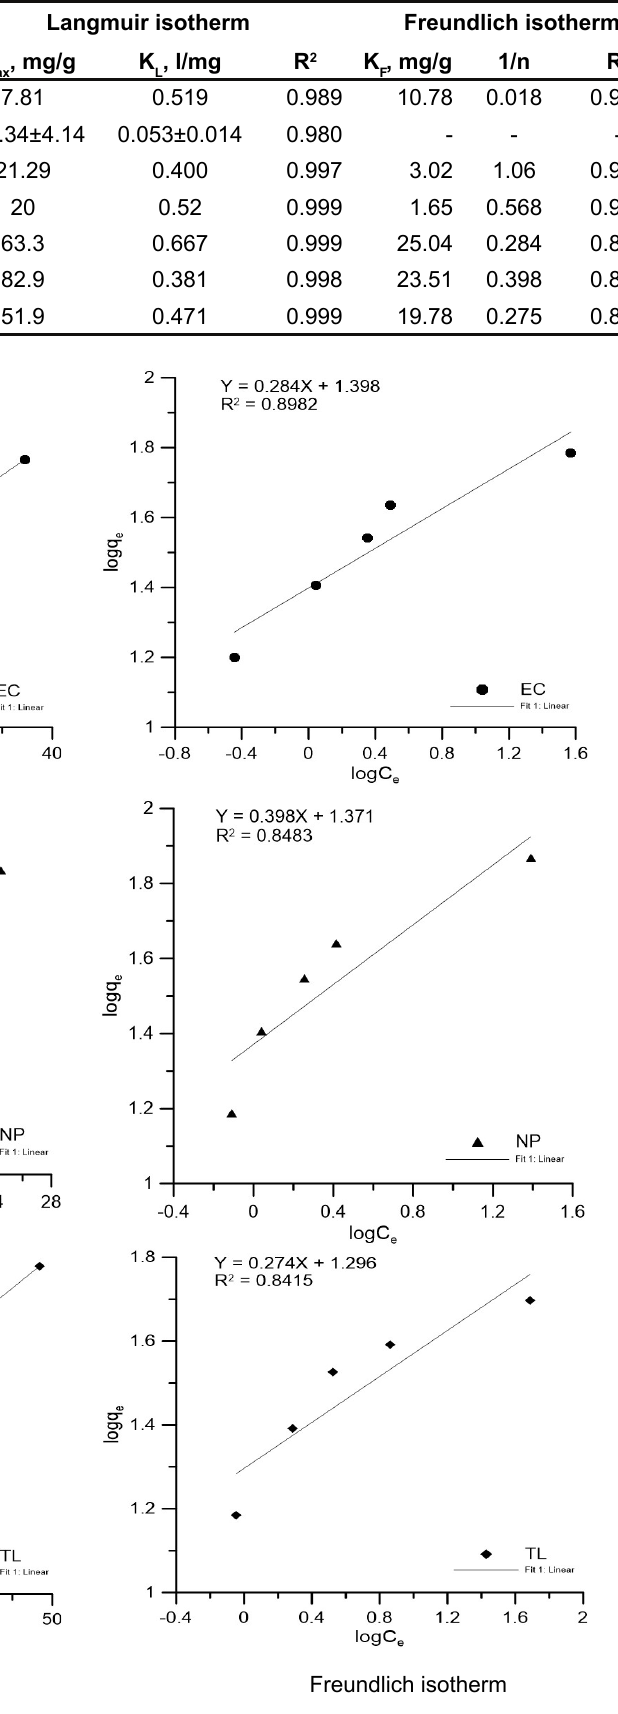
Fig. 5. Langmuir and Freundlich isotherm curves of each biosorption